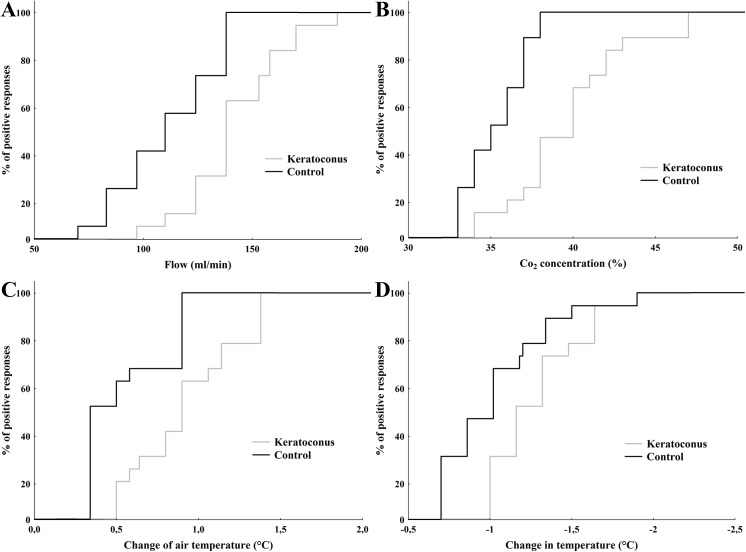
Cumulative distribution of sensation thresholds to selective stimulation of the central cornea in control subjects and keratoconus patients.(A) air pulses of increasing flow (mechanical stimulation), (B) pulses with increasing CO2 concentration (chemical stimulation), (C) pulses of air at increasing temperatures (hot thermal stimulation), and (D) pulses of air at decreasing temperatures (cold thermal stimulation), in KC patients (gray line) and controls (black line).